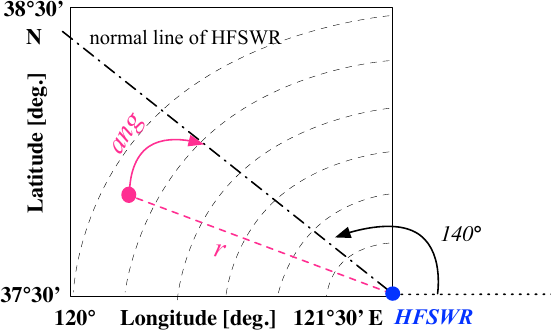
Figure 4. Coordinate system